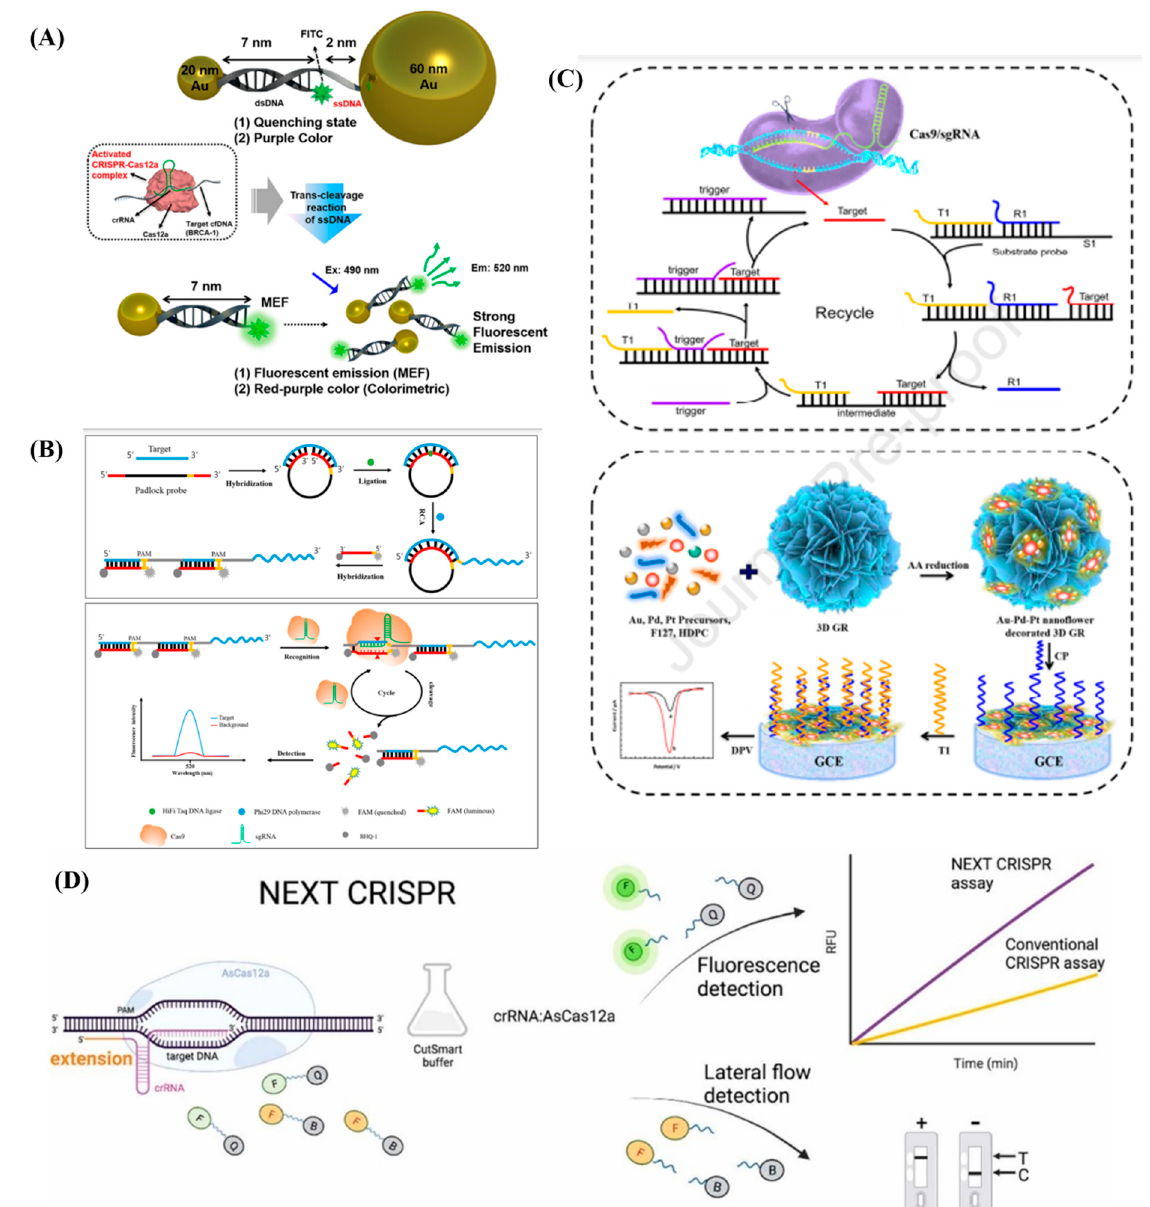
Figure 6. ( A ) Schematic illustration of cfDNA detection. Re-used with permission from Ref. [64]. (Copyright 2021, American Chemical Society). ( B ) Overall reaction mechanism of RACE. Re-used